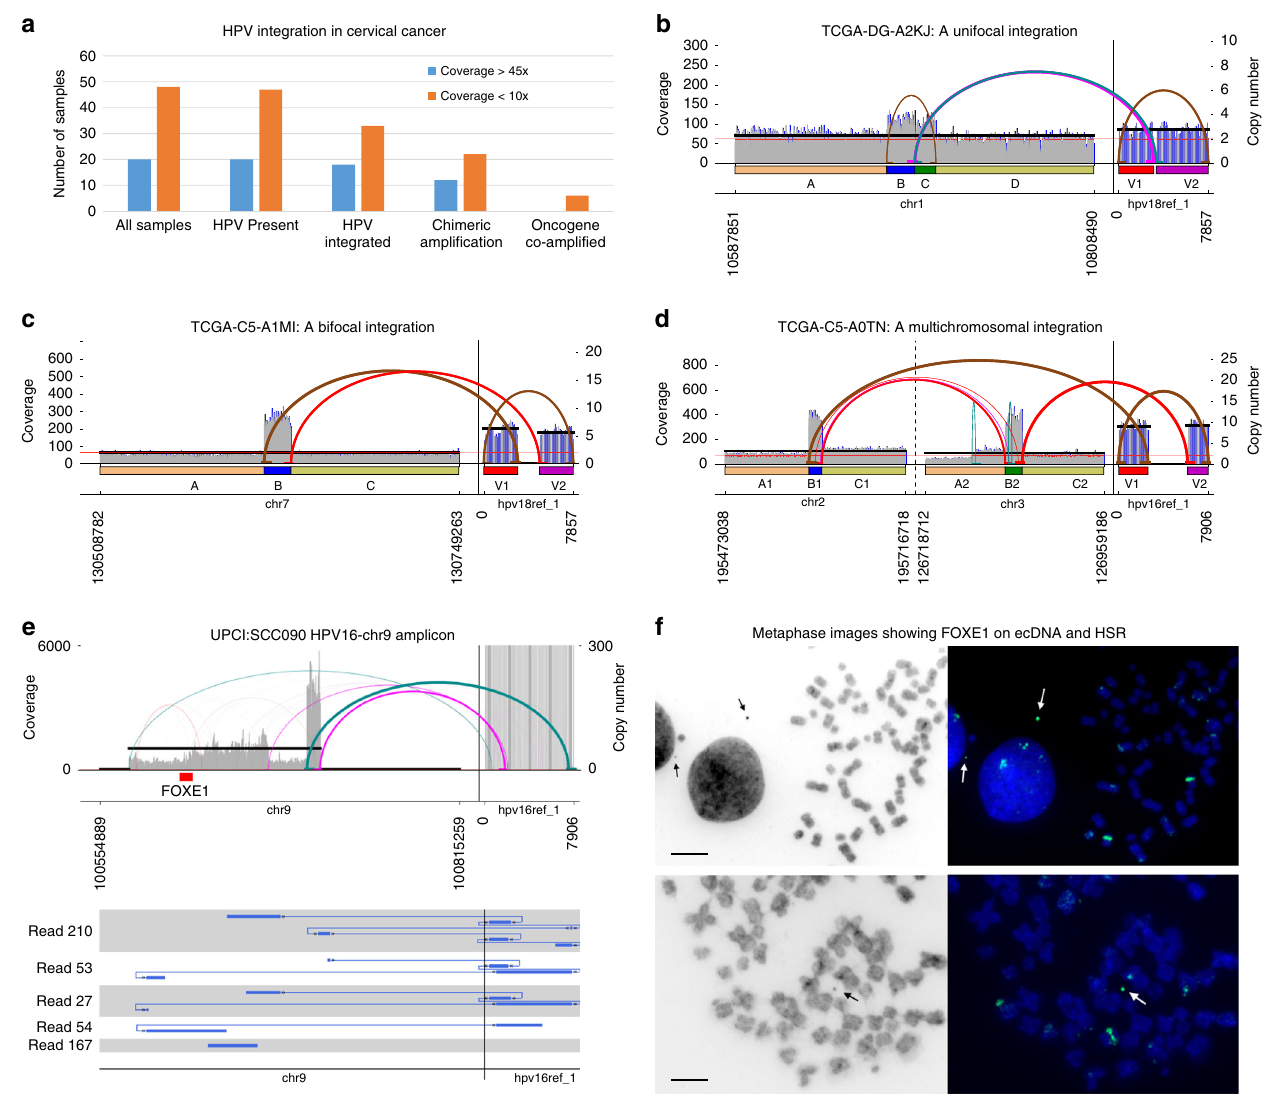
Fig. 4 Amplicon structures near viral insertions. a Human papillomavirus (HPV) sequence was identi fi ed in 67 of 68 tumor whole-genome sequencing (WGS) samples (with genomic integration in 51) compared with 0 of 68 in matched normal blood samples. Forty-one fusion amplicons were reconstructed in 33 samples (Supplementary Data 7, 8). b Although 14 of the viral insertions gave a unifocal ampli fi cation signature, consistent with viral insertion at a speci fi c genomic location, c 32 amplicons showed a bifocal signature. d A two-way bifocal signature in sample TCGA-C5-A0TN with two segments from chr2 and chr3 connected to a viral segment in a circular or tandemly duplicated structure with 10 copies. The prevalence of bifocal signatures is suggestive of hybrid extrachromosomal DNA (ecDNA) elements containing virus and human sequence (Supplementary Data 8). e AA reconstruction of a complex hybrid structure (>100 kbp) containing the oncogene FOXE1 . The Cycle view shows paths traced by PacBio reads validating the AmpliconArchitect (AA) structures. f Metaphase images of cells in metaphase of UPCI:SCC090 stained with DAPI (left: black, right: blue) and FISH on a FOXE1 probe (green) indicating the presence of ecDNA (arrow), as well as numerous HSRs containing FOXE1 . Sizes of the black bars in the DAPI images correspond to 200 μ